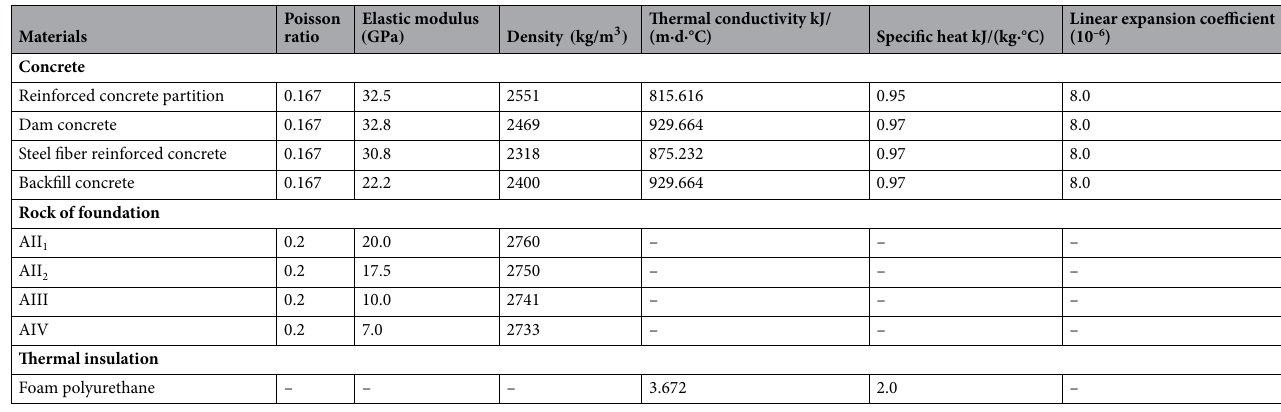
Table 3. Mechanical and thermodynamic parameters for numerical simulation. Based on the characteristics and properties, the rock of foundation is divided into four categories: AII1, AII2, AIII and